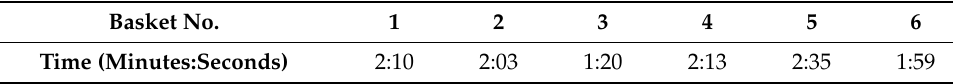
Table 4. The time elapsed for the disintegration of capsules. Basket